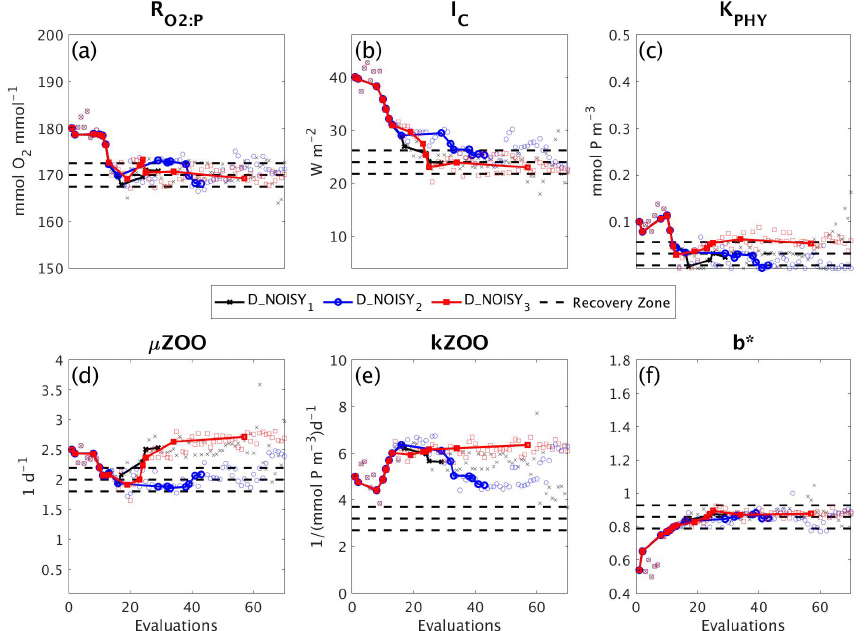
Figure 11. As in Fig. 9, but for the experiments D_NOISY 1 (black line with crosses), D_NOISY 2 (blue line with circles) and D_NOISY 3 (red line with squares).